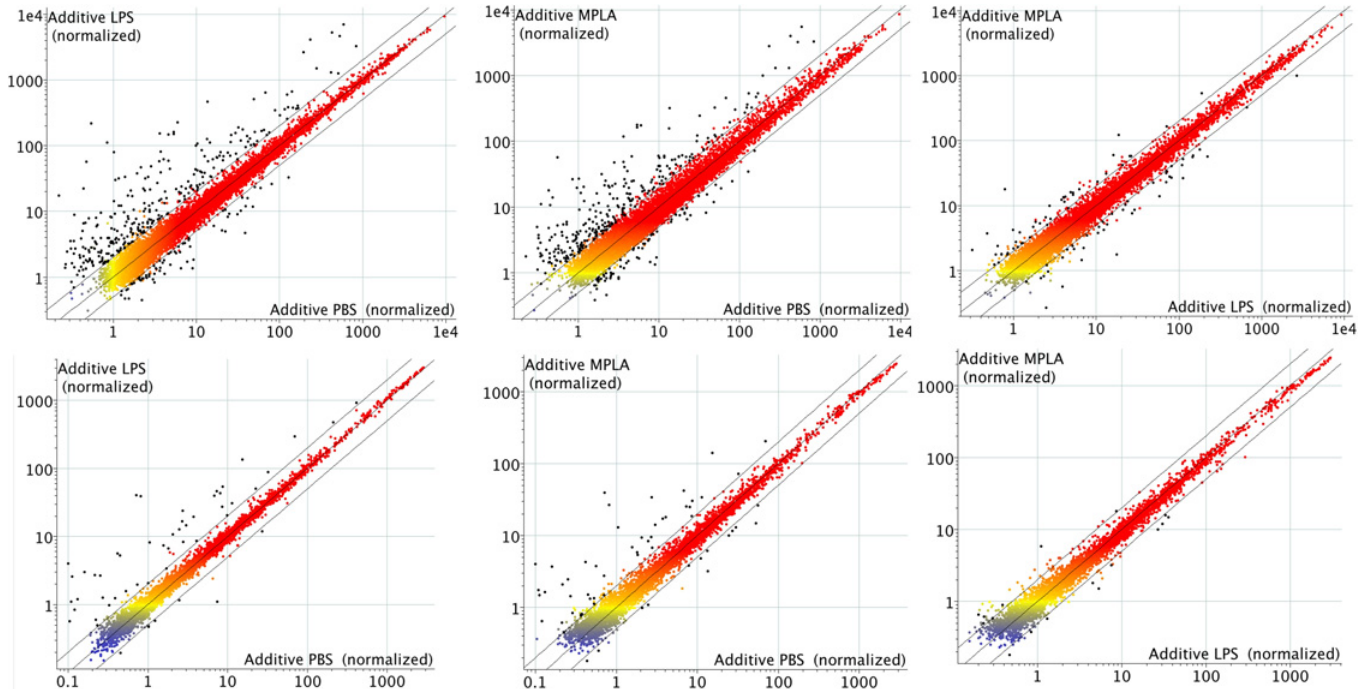
Fig 2. Scatter plots of probes above background in at least 4 of 6 replicates in any group (4,992 sheep probes, 11,431 human probes). Intensity values are normalized to the 75th percentile intensity of each array. Diagonal lines indicate 2-fold differential expression. Red/Orange: high expression; yellow: medium expression; blue: low expression; and black: probes that pass 2-fold and paired T-test p-value < 0.05 cutoffs. Top row: Human. Bottom row: Sheep.